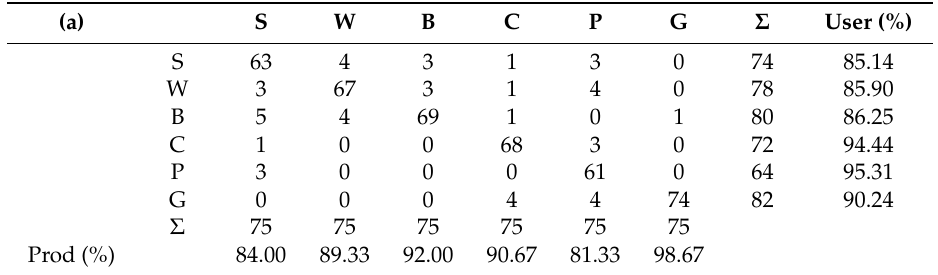
Table 5. Confusion matrices for classifications by the SVM using training sets containing